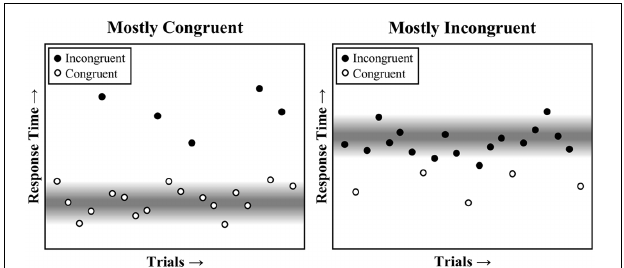
FIGURE 2 | A visual representation of task pace on performance across a series of trials in the mostly congruent and mostly incongruent conditions. The response threshold is diminished at the expected time to respond (gray), speeding any trials that can benefit from this reduced threshold. This primarily benefits congruent trials in the mostly congruent condition and incongruent trials in the mostly incongruent